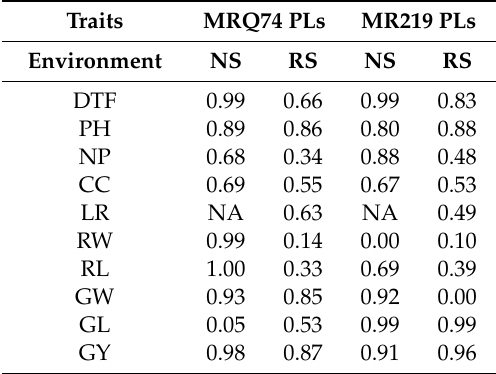
Table 3. Heritability of each trait in each population under NS and RS.